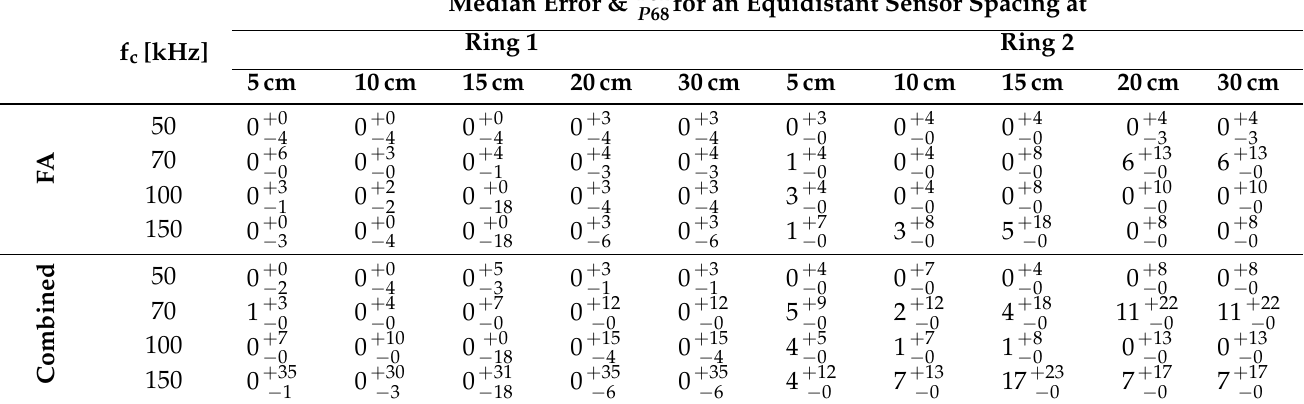
Table A2. Accuracy of the measured sand levels.